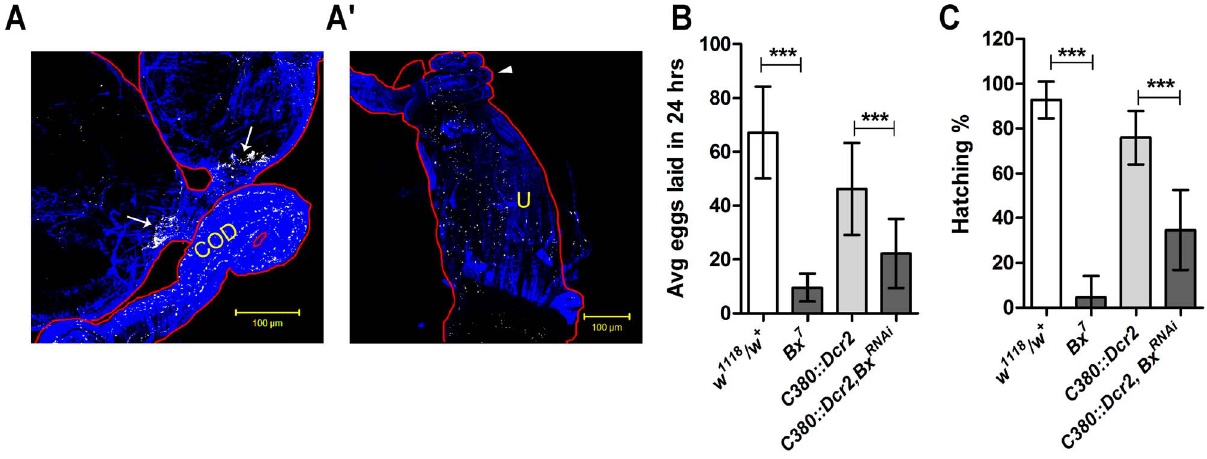
Figure 6. Bx function in the motor neurons is important for the female reproduction. (A, A’) C380-Gal4 neurons driving expression of Syt - eGFP showed their projections on to most of the female reproductive tract muscles like oviduct (white arrows), common oviduct (COD), seminal receptacle (white arrow head) and uterus (U). Knock down of Bx in C380 motor neurons significantly reduced the female fecundity (B) and fertility (C) which can be compared to that of the Bx 7 mutant females (unpaired t test, ***, p , 0.0001). Blue indicates Phalloidin-TRITC and white indicates syt - eGFP.